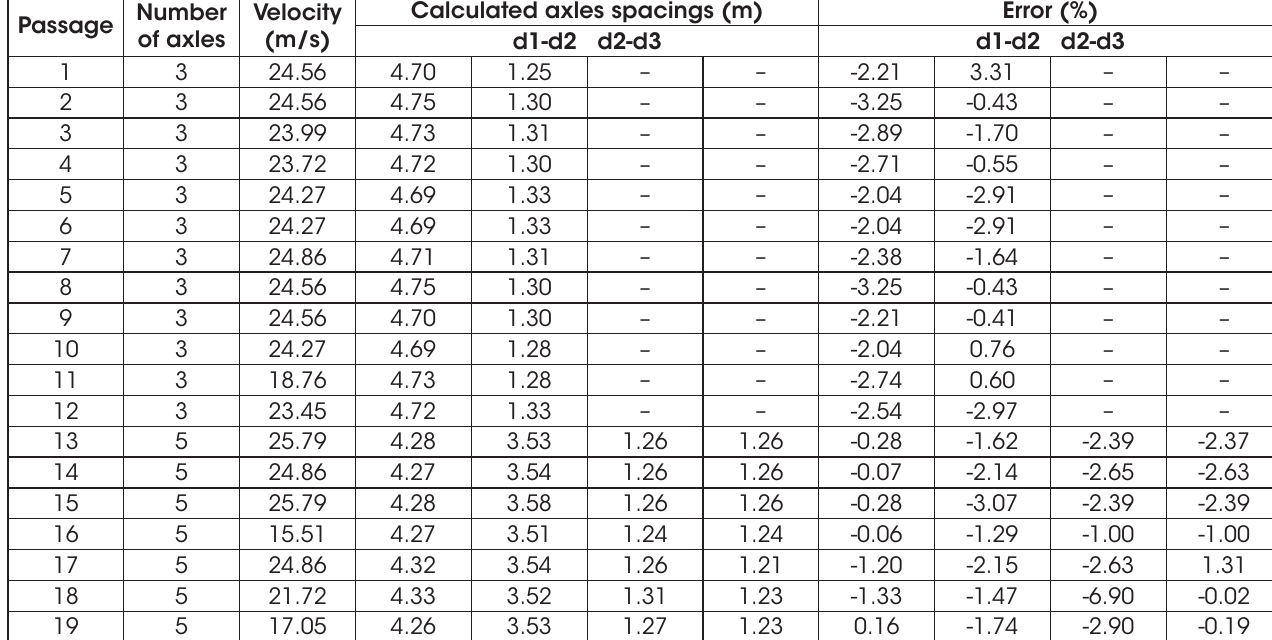
Velocities and axles spacings obtained with FAD sensors for lane 2 Number Passage of axles